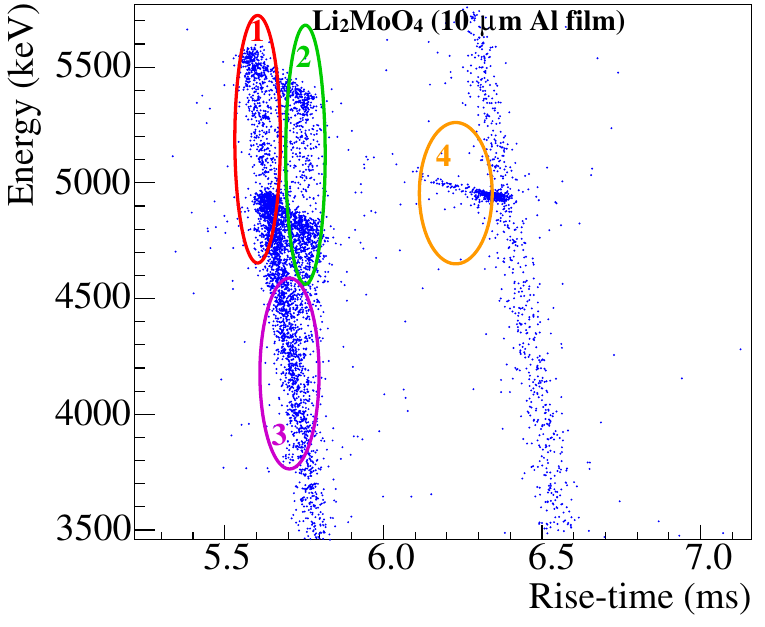
Figure 5 . Energy as a function of the rise-time for a Li 2 MoO 4 bolometer (Detector 1 in table 1), with a 20 (cid:2) 20 mm side covered by the Al (cid:12)lm and illuminated by an uranium source. The di(cid:11)erent populations evidenced in the four colored ovals are discussed in the text. As for the energy of the (cid:11) and neutron-capture events, see caption of (cid:12)gure 4.